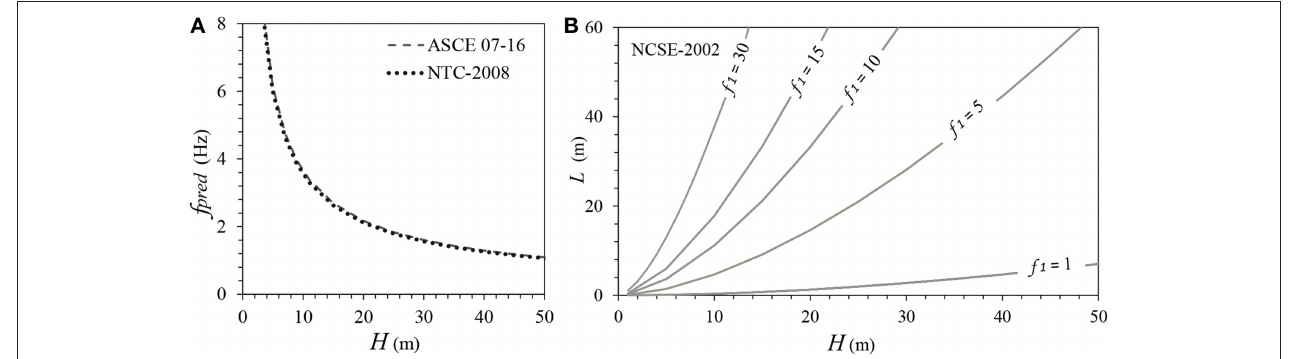
FIGURE 1 | Estimation of the fundamental frequency with the (A) formulations proposed by ASCE 07-16 and NTC-08 and (B) with the formulation proposed by